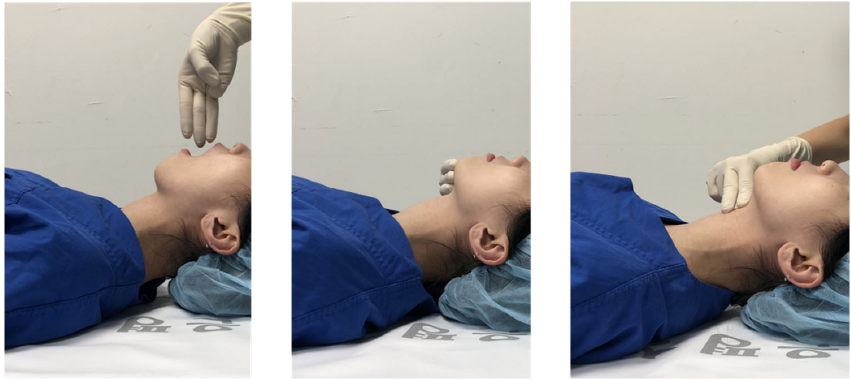
Figure 2. The “3 ‐ 3 ‐ 2 rule” for assessing the airway before induction of